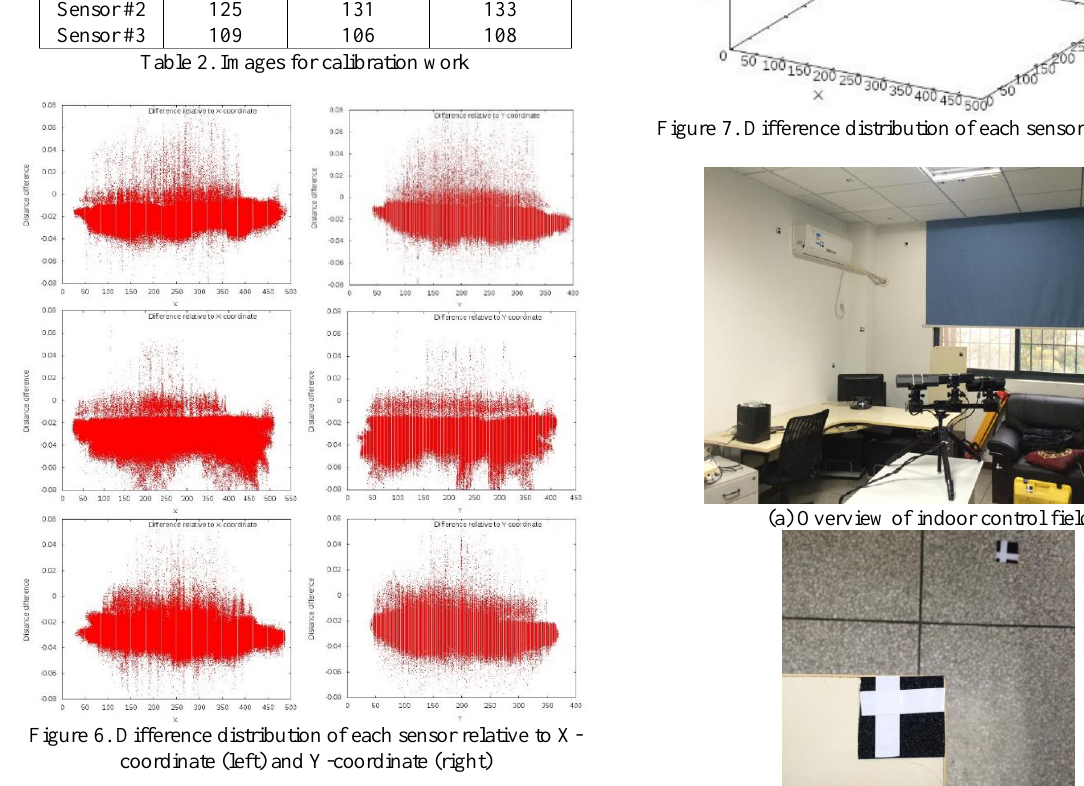
Figure 6. Difference distribution of each sensor relative to X- coordinate (left) and Y-coordinate (right)